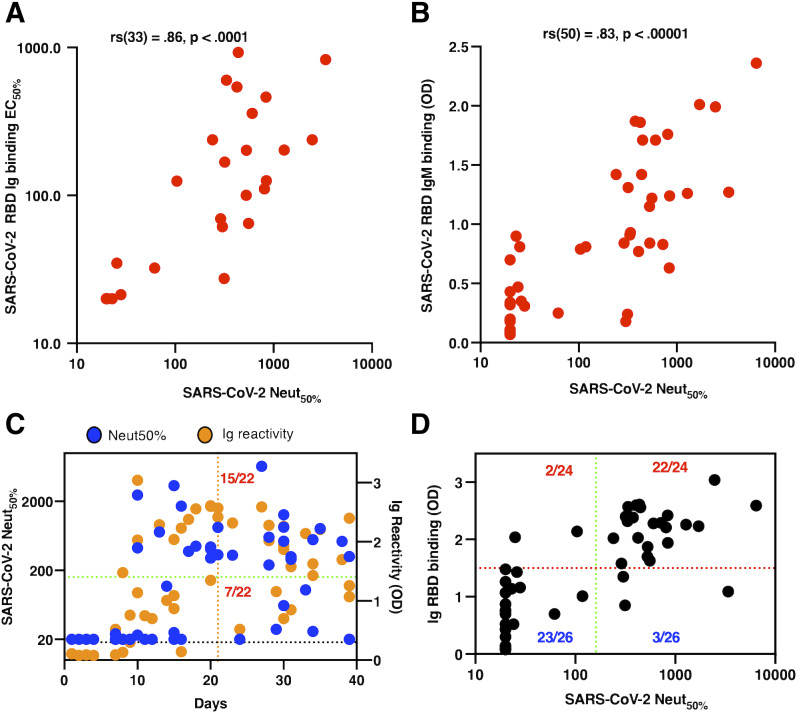
Correlation between spike RBD antigen binding and SARS-CoV-2 neutralizing antibody titers.Correlations between (A) total Ig and (B) IgM RBD binding and the SARS-CoV-2 neutralizing antibody titers. Scatter plots were generated using individual serum binding to RBD antigen (y-axis) versus SARS-CoV-2 neutralizing antibody titers (x-axis). The nonparametric Spearman correlation coefficient (rs) and the associated two-tailed p-value were calculated (GraphPad Prism, version 5.0). (C) Relationship between SARS-CoV-2 neutralizing antibody titer and days after onset of symptoms. (D) Total Ig antibody binding to RBD as a surrogate for identifying people with high SARS-CoV-2 neutralizing antibodies. A total of 50 serum samples collected between 1 and 39 days after onset of symptoms from PCR-confirmed SARS-CoV-2 subjects were measured for Ig and IgM binding to spike RBD antigen and SARS-CoV-2 neutralization assay. The FDA-recommended neutralizing antibody titer for plasma therapy (1:160) is indicated by the broken green line.